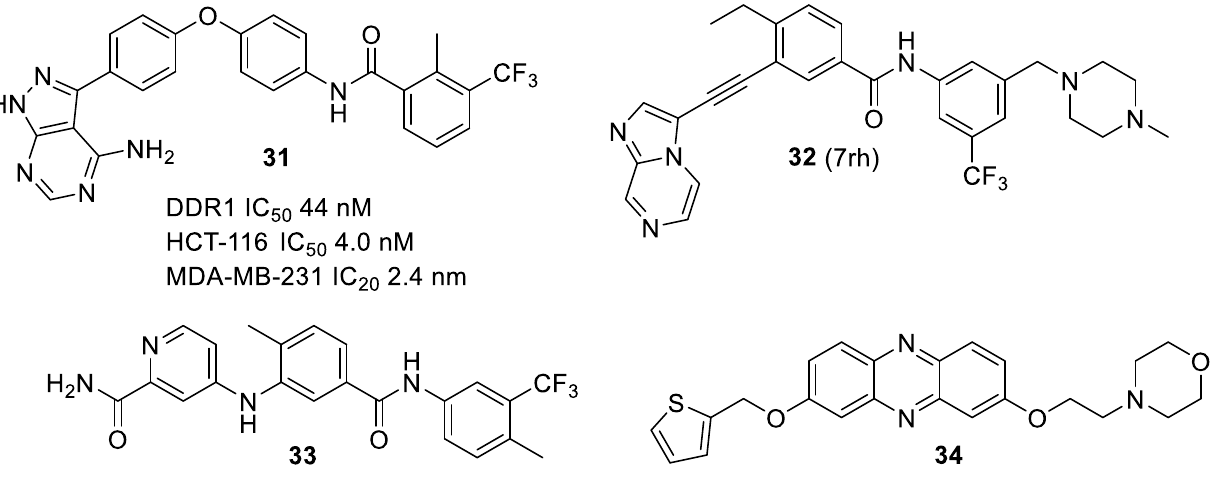
Figure 7. DDR inhibitors in cancer treatment.